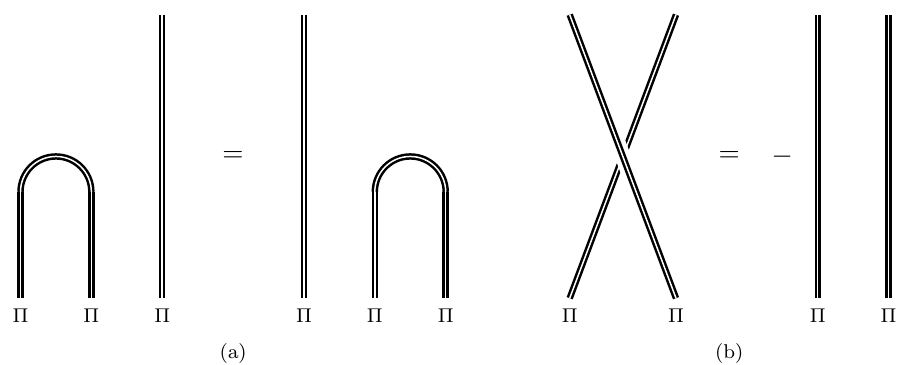
Figure 18 . (a) A property of bulk line (cid:5) generating an anomalous Z 2 1-form symmetry. (b) Half-braiding (cid:5) lines across each other gives a factor of (cid:0) 1 when compared to (cid:5) lines without